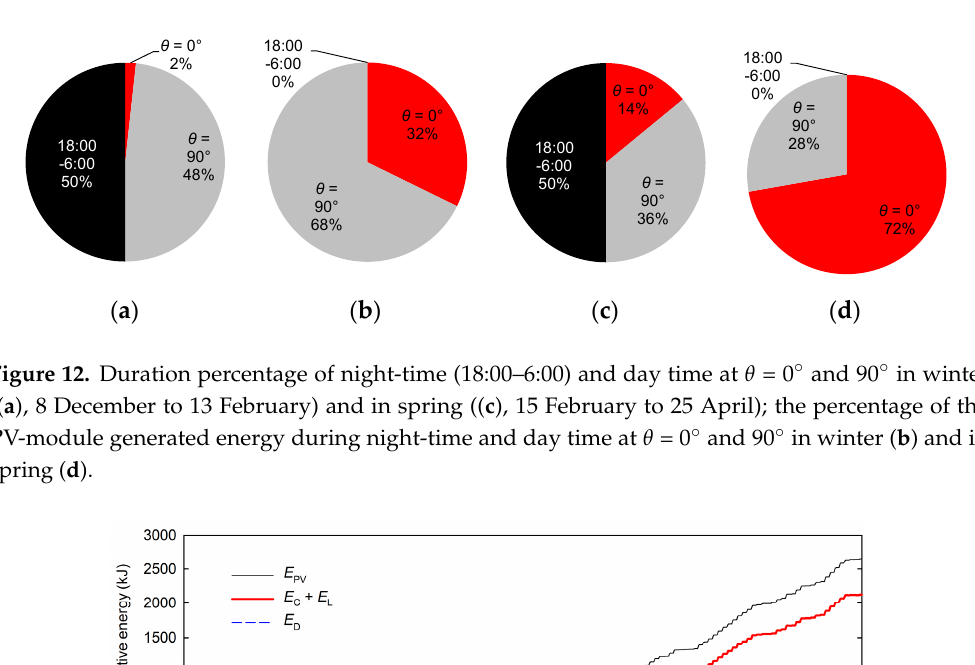
Figure 11. PV blind operations on 12 January ( a ) and 19 April ( b ).